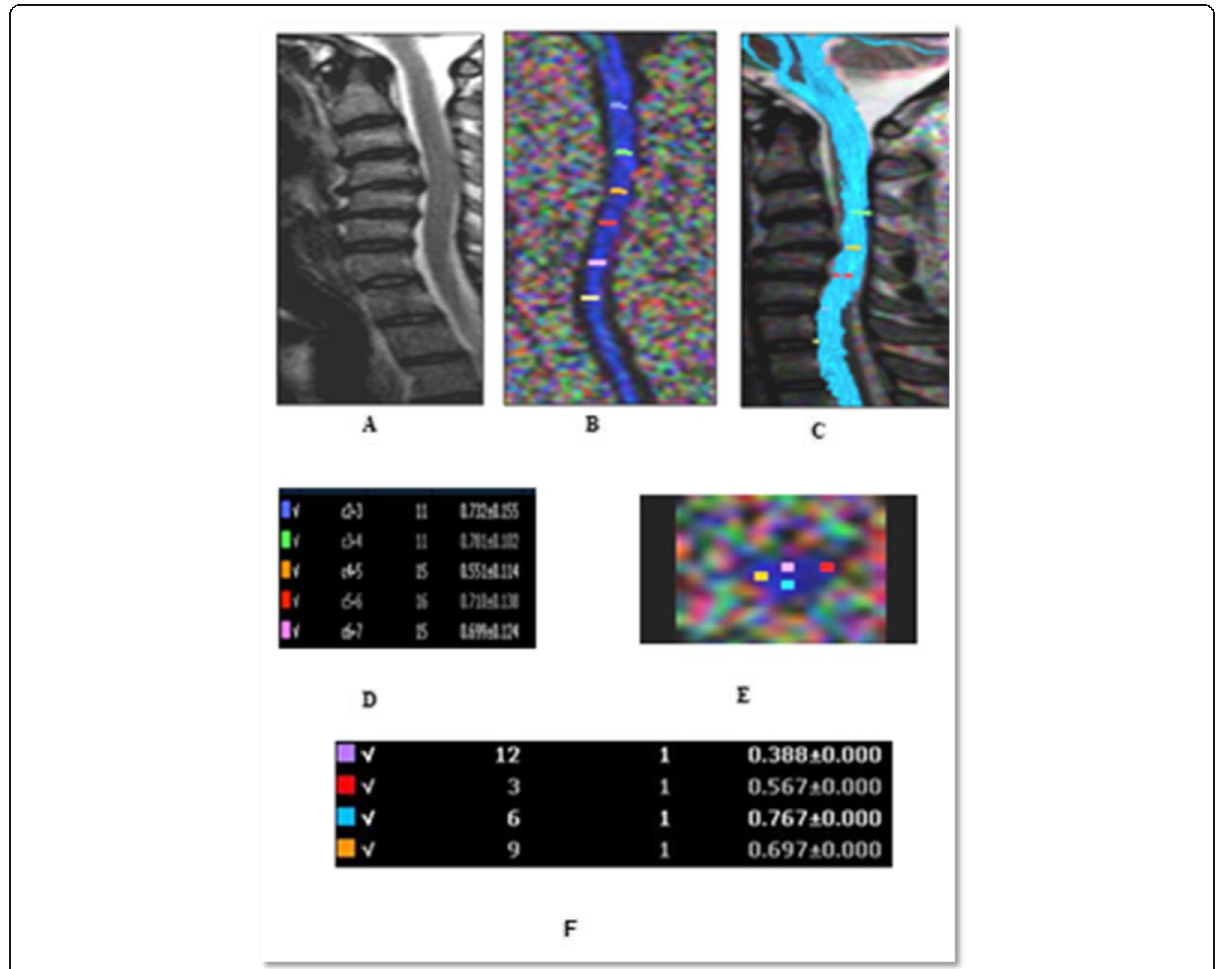
Fig. 4 Fifty-year-old female patient presented with neck pain. a Sagittal T2 WI of the cervical spine showing C3-4, C4-5, C5-6, and C6-7 posterior disc lesions, more prominent at C4-5 level, where it is seen indenting the cord, with no signal intensity alteration of the cord. b Color-coded FA map of the cervical cord with multiple ROIs opposite to different disc levels. c DTI fiber tractography of the cervical cord showing grossly intact white matter fibers. d FA values opposite to all the examined cervical discs, showing mild reduction of FA value of the whole cord circumference opposite to the C4-5 disc level (the most affected disc level) denoting myelopathy. e , f FA values of the spinal cord at 3, 6, 9, and 12 o ’ clock positions opposite to C4-5 disc, showing the reduction in FA value is more pronounced opposite to 12 o ’ clock